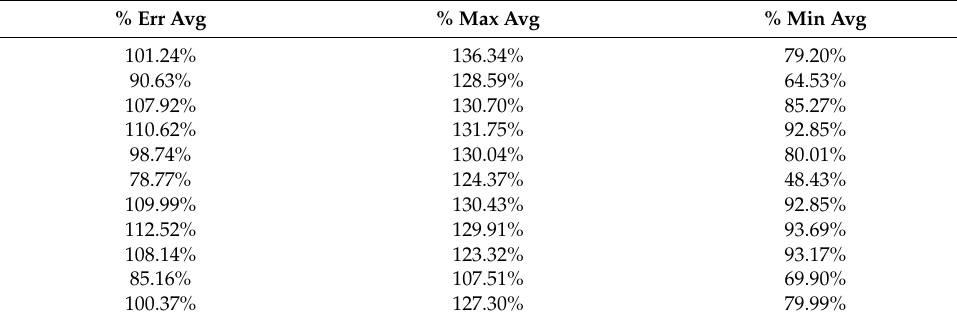
Table A105. Set 2, trials 11–20 data (all 0.5 PR values).